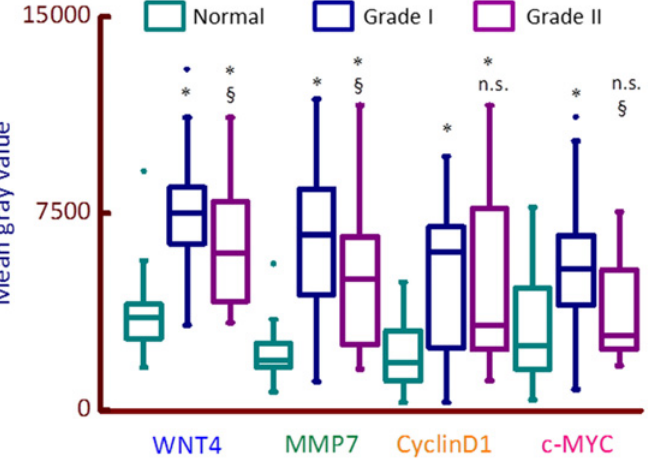
Fig 2. Box plot of the quantitation of expression of WNT4, MMP7, CD1 and c-MYC in PeCa tissue classified according to pathological grade. 97% of the samples used in this study were classified as grade I or II. The data presented in Table 1 was segregated into expression according to pathological grades and plotted as box plots. Filled circles are 99% value and horizontal line within the box is the median value. Protein expression (mean gray value per core) in control samples (green, n = 37); malignant tumor sample classified as grade I by a pathologist (blue, n = 82) or grade II (purple, n = 18). All proteins showed a significant difference in expression between control and malignant tumor samples. Significance of difference was measured using Mann-Whitney U test: * = p < 0.001 and § = p < 0.01 between control and malignant grade I or grade II samples or within grade I and grade II. There was no significant difference in protein expression for any marker between grade I and grade II